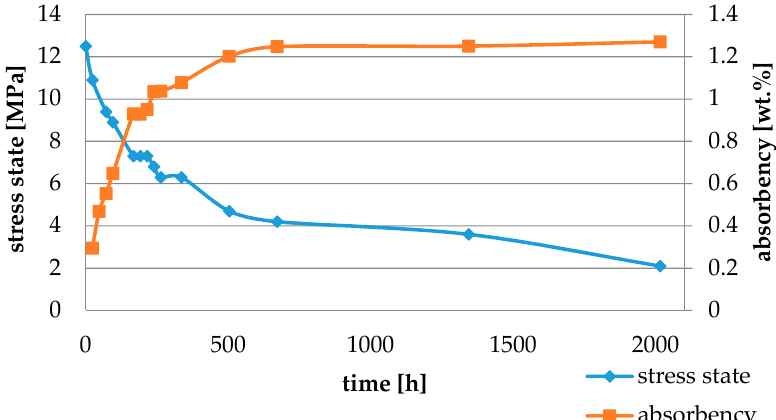
Figure 6. The influence of water sorption (2016 h water ageing) on the absorbency and contraction stress generated during the photopolymerization of Multilink Automix.